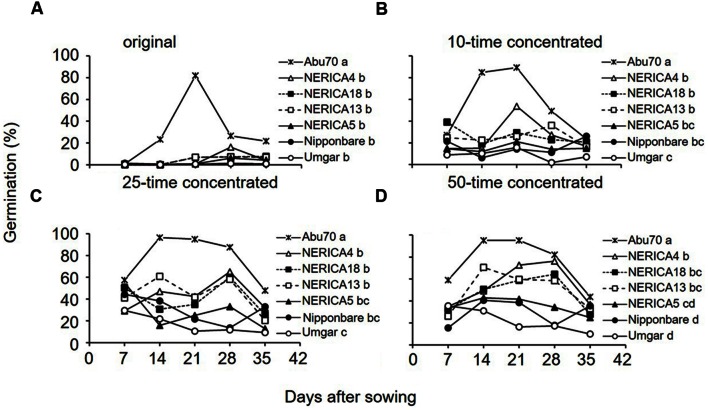
Germination inducing activity of root exudates from Umgar, NERICA5, NERICA13, Nipponbare, NERICA4, and NERICA18 grown in a growth chamber. Original (A), 10-time concetrated (B), 25-time concentrated (C) and 50-time concetrated (D) root exudates were used in the germintion test. The percentage values were arcsine transformed, compared by multiple mean-separation tests among rice and sorghum varieties and back-transformed. Different letters next to variety name indicate significant difference (p < 0.05) by Tukey’s HSD test pooled across sampling date.